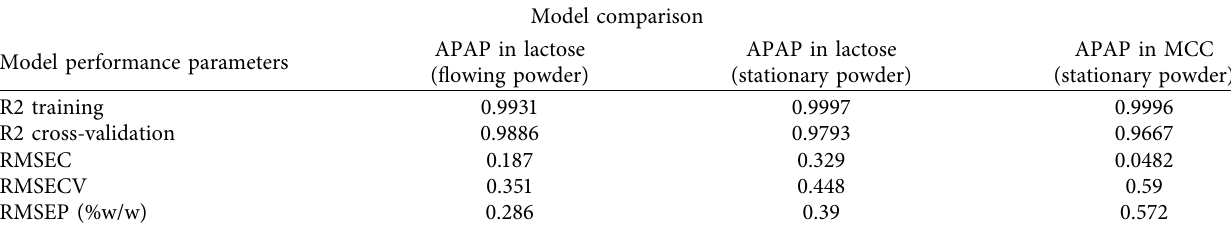
Table 3: Comparison of PLS